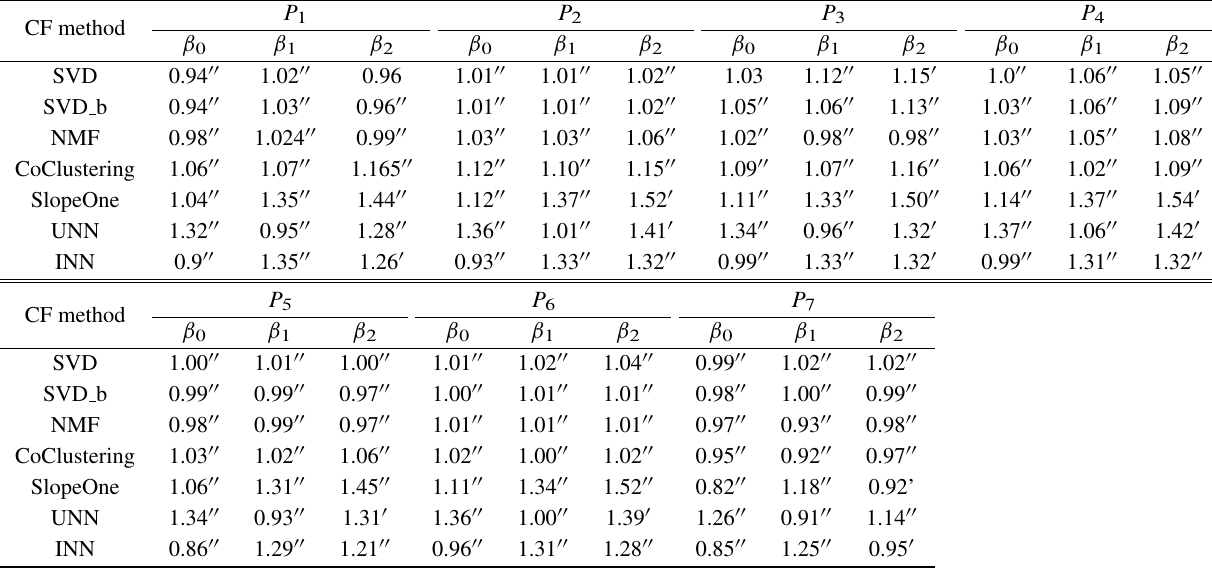
Table 3 Results of regression analysis of TTI using model in Eq.